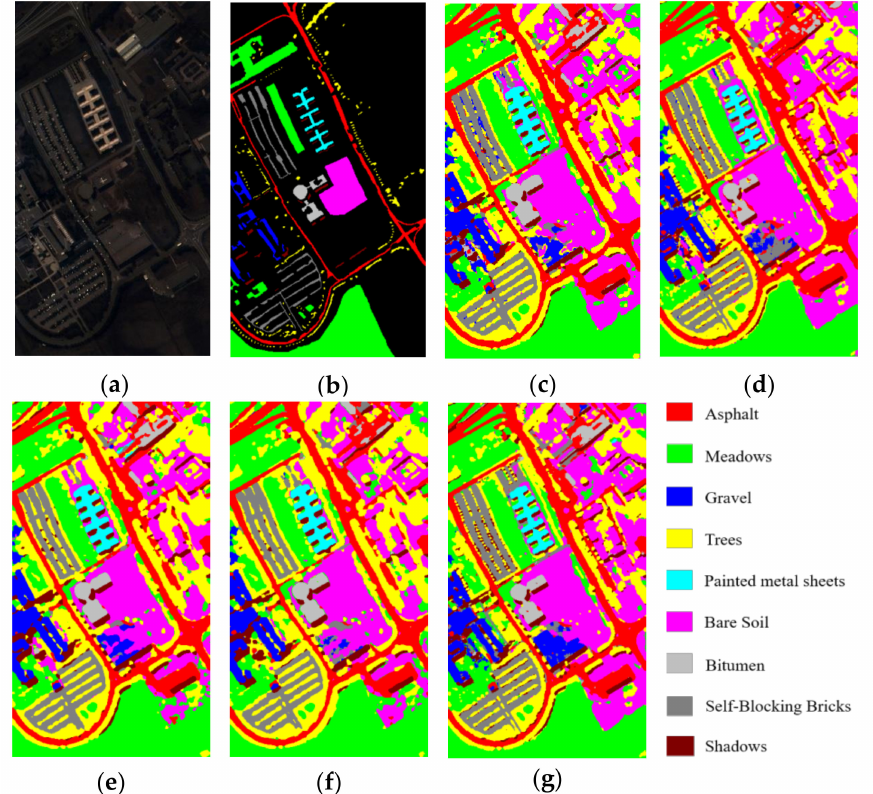
Figure 11. Classification results of the models in comparison with the UP dataset. ( a ) False color image.